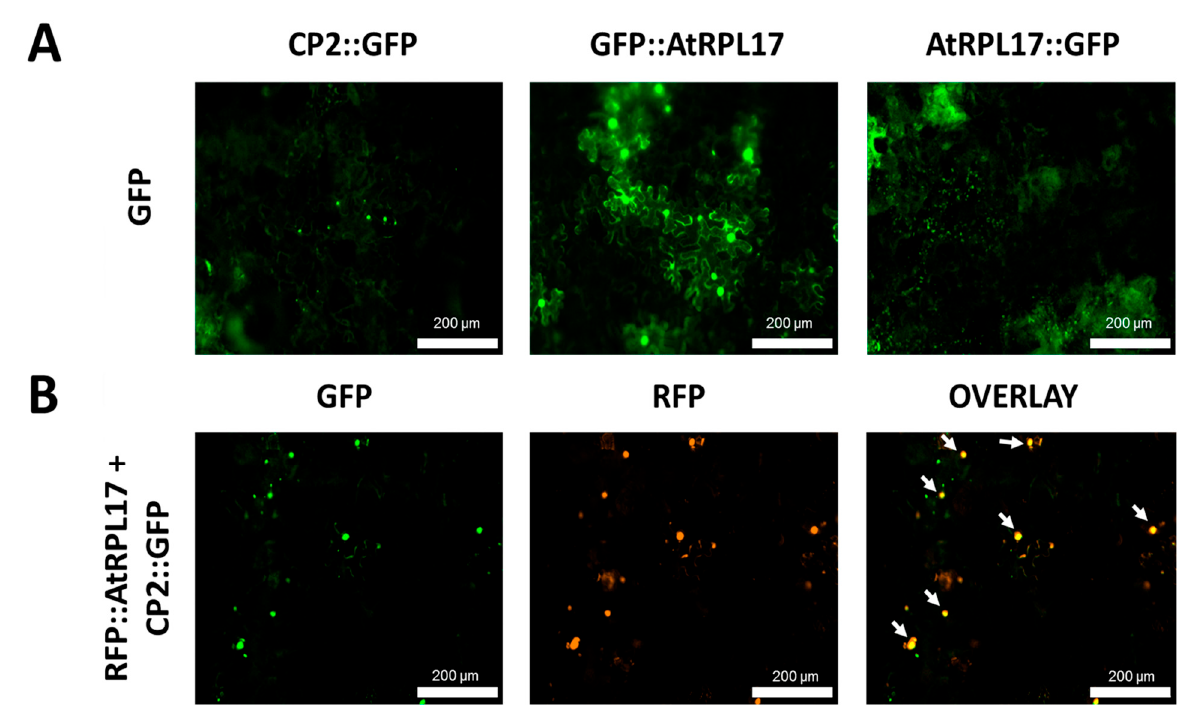
Figure 4. Transient expression and co-localization of At RPL17 and CP2 in Nicotiana benthamiana . ( A ) Localization of green fluorescent protein (GFP)-fused At RPL17 and CP2 proteins (CP2::GFP, At RPL17::GFP, and GFP::AtRPL17) in leaf epidermal cells of N. benthamiana visualized at 2 days post-infiltration. ( B ) Co-localization of At RPL17 and CP2 expressed as fusions to (GFP) or red fluorescent protein (RFP) in N. benthamiana epidermal leaf cells. Right column image is GFP and RFP overlayed channels. The fusion proteins RFP:: At RPL17 were expressed along with GFP::CP2. White arrows: co-localization signals.